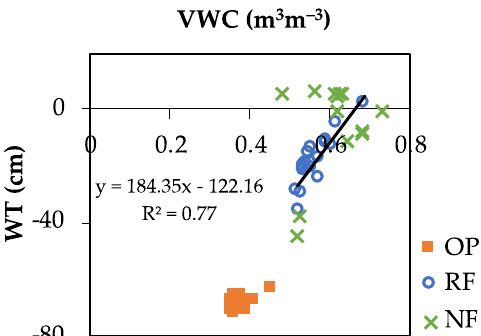
represent standard error of the mean. Note: different letters in red represent significantly different, α = 0.05 .